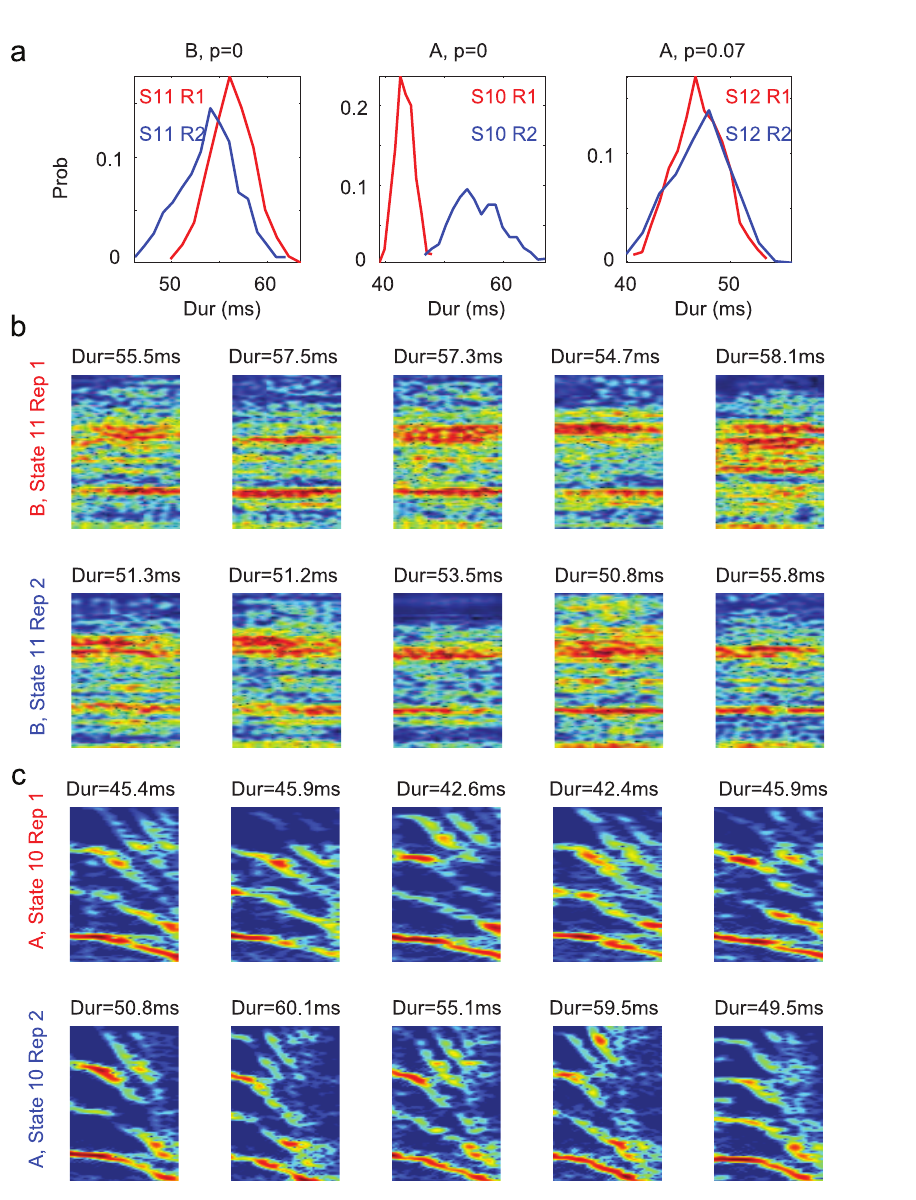
Figure 12. Evidence of different states representing the repeating syllables. a. The duration distributions of the syllables occurring the first (red curves) and the second (blue curves) in the repetitions are compared for syllable B associated with state 11 (left), syllable A associated with state 10 (middle), and syllable A associated with state 12 (right) in the POMM of Bird 2 shown in in Figure 9a. The p -values on top test the significance that the differences of the means of the two distributions are non-zero. b. Spectrograms of randomly selected examples of syllables B occurring the first (top) and the second (bottom) in the repetition in state 11. c. Same as in b but for syllable A in state 10. Durations of the syllables are shown on top. Frequency range of the spectrograms is from